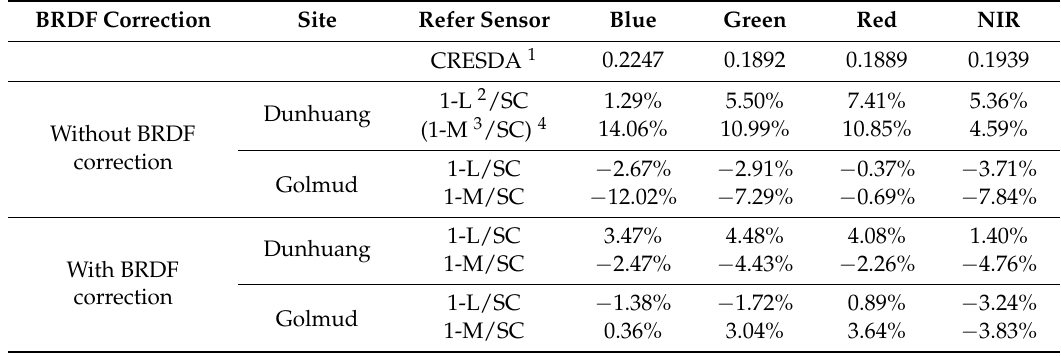
Table 5. Site calibration coefficients and the relative error between cross-calibration coefficients and site calibration coefficients.